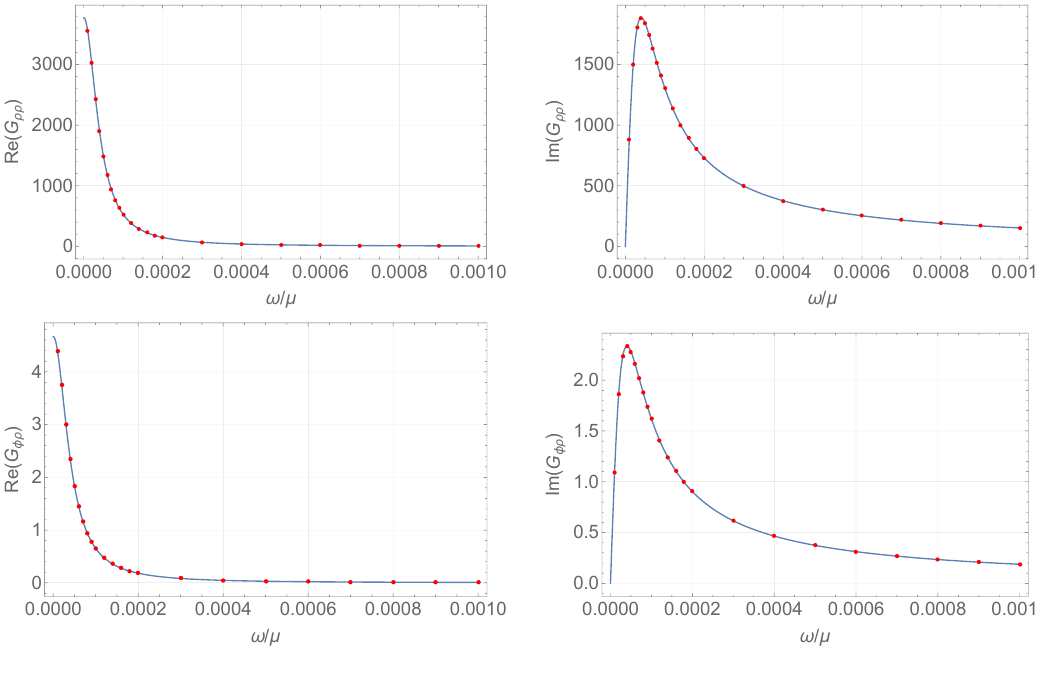
Figure 3 . Real and Imaginary part of the Green’s functions. Analytic results are displayed in dashed lines, while numerical results are show with black dots. Here φ s = 1 , q = 1 , µ = 1 , ζ ρ = 0 , ζ φ = 0 , λ φ = 1 , λ ρ = 1 / 4 , λ = − 3 / 4 and T/T c = 0 . 999957